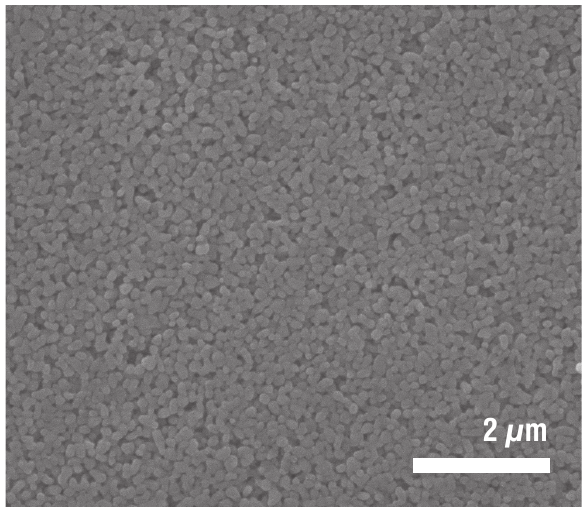
Figure 2: Scanning electron micrograph of the inner surface of the AKP- 15 α -alumina support sintered at 1200 °C.